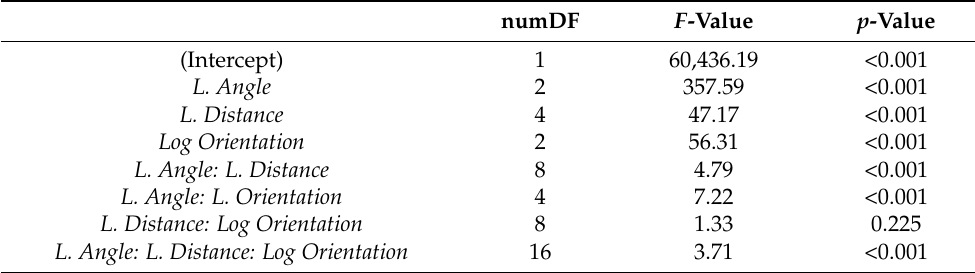
Table 2. Analysis of variance of the linear model (using generalized least-squares), fitted to reciprocal values of time consumption required for loading (L.) cycles of a forwarder.